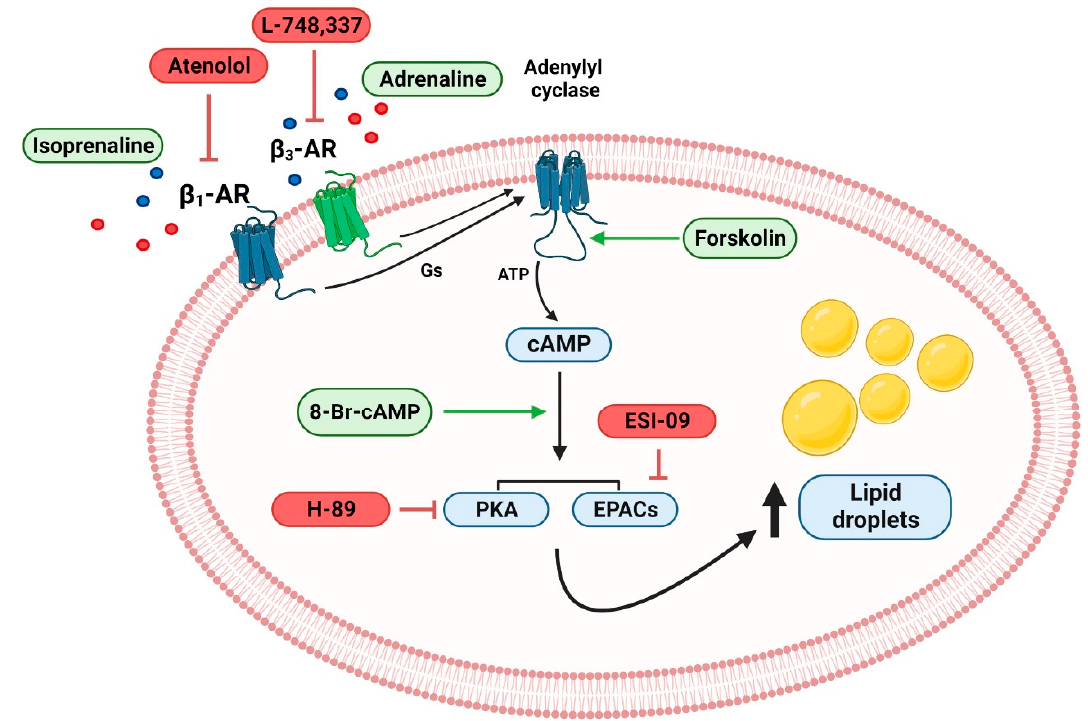
Figure 6. β 1 - and β 3 -adrenoceptors drive lipid droplet expansion in MCF-7 breast cancer cells via cAMP/PKA/EPAC proteins. Drugs tested are shown in green (those used to mimic stimulation of the pathway) and red boxes (those used to block the pathway). AR: adrenoceptor; EPACs: cAMP- dependent guanine-nucleotide-exchange factors; PKA: protein kinase A.